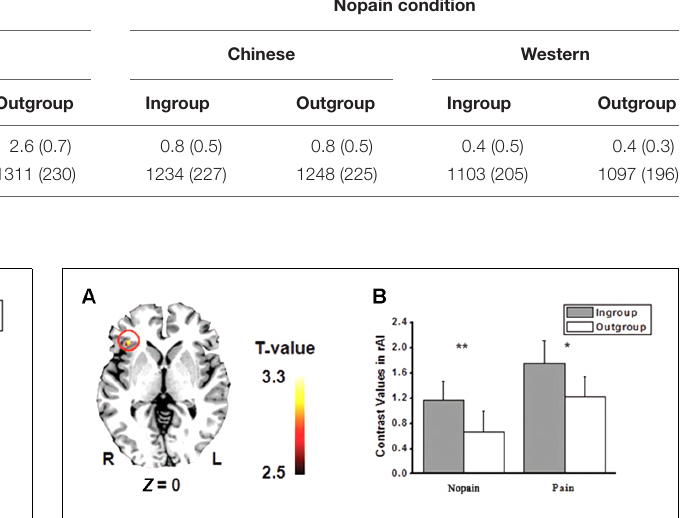
FIGURE 3 | (A) Activity of right anterior insula (rAI) was modulated by minimal group ( p < 0.005, small volume corrected). (B) Ingroup models elicited stronger rAI activity than that of Outgroup models both in the pain and in the nopain conditions (SE). ∗ p = 0.05, ∗∗ p < 0.02,